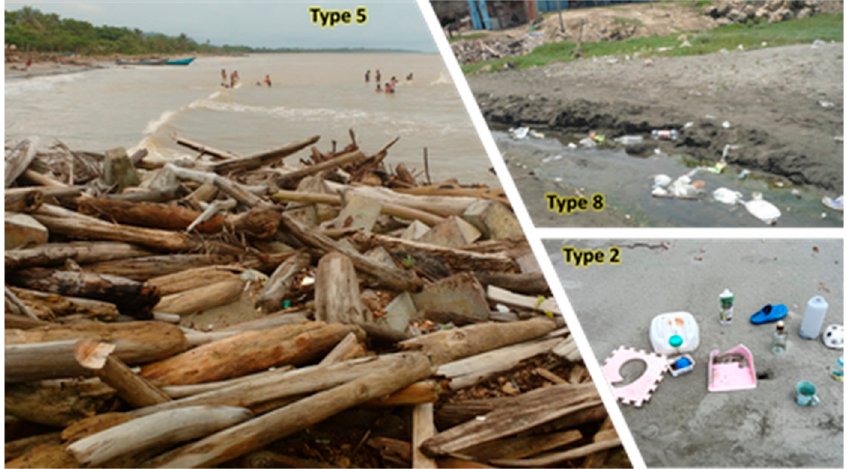
Figure 4. Example of beach litter categories 2 (river transported), 5 (gross vegetation) and 8 (gross polystyrene).